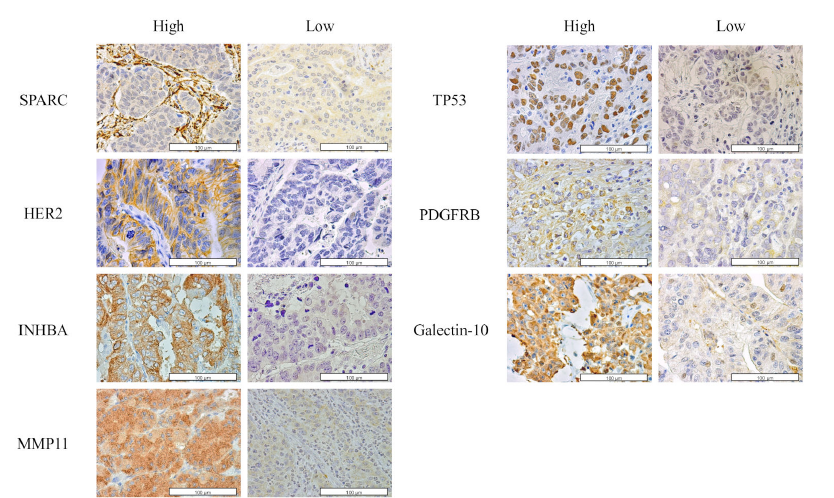
Figure 2. Immunohistochemical status of the candidate survival risk stratification markers se- creted protein acidic and rich in cysteine (SPARC), Human Epidermal Growth Factor Receptor 2 (HER2),inhibin subunit beta A (INHBA), matrix metallopeptidase 11 (MMP11), tumor protein P53 (TP53), and platelet-derived growth factor receptor-beta (PDGFRB), and galectin-10 identified by quantitative polymerase chain reaction (qPCR) and proteomic analysis. Representative images of high and low immunostaining of each candidate marker are shown.